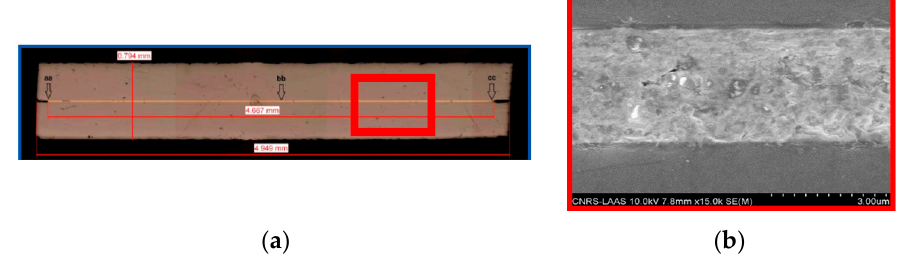
Figure 3. Ring cross section view, Optical image after polishing ( a ); SEM image after FIB etching ( b ).